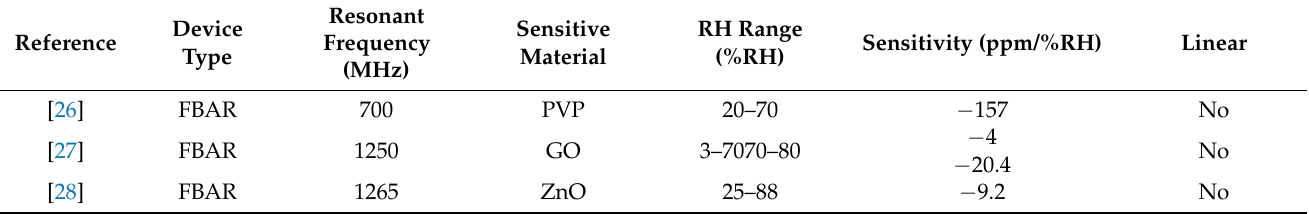
Comparison of the performance of piezoelectric resonant humidity sensors in previous